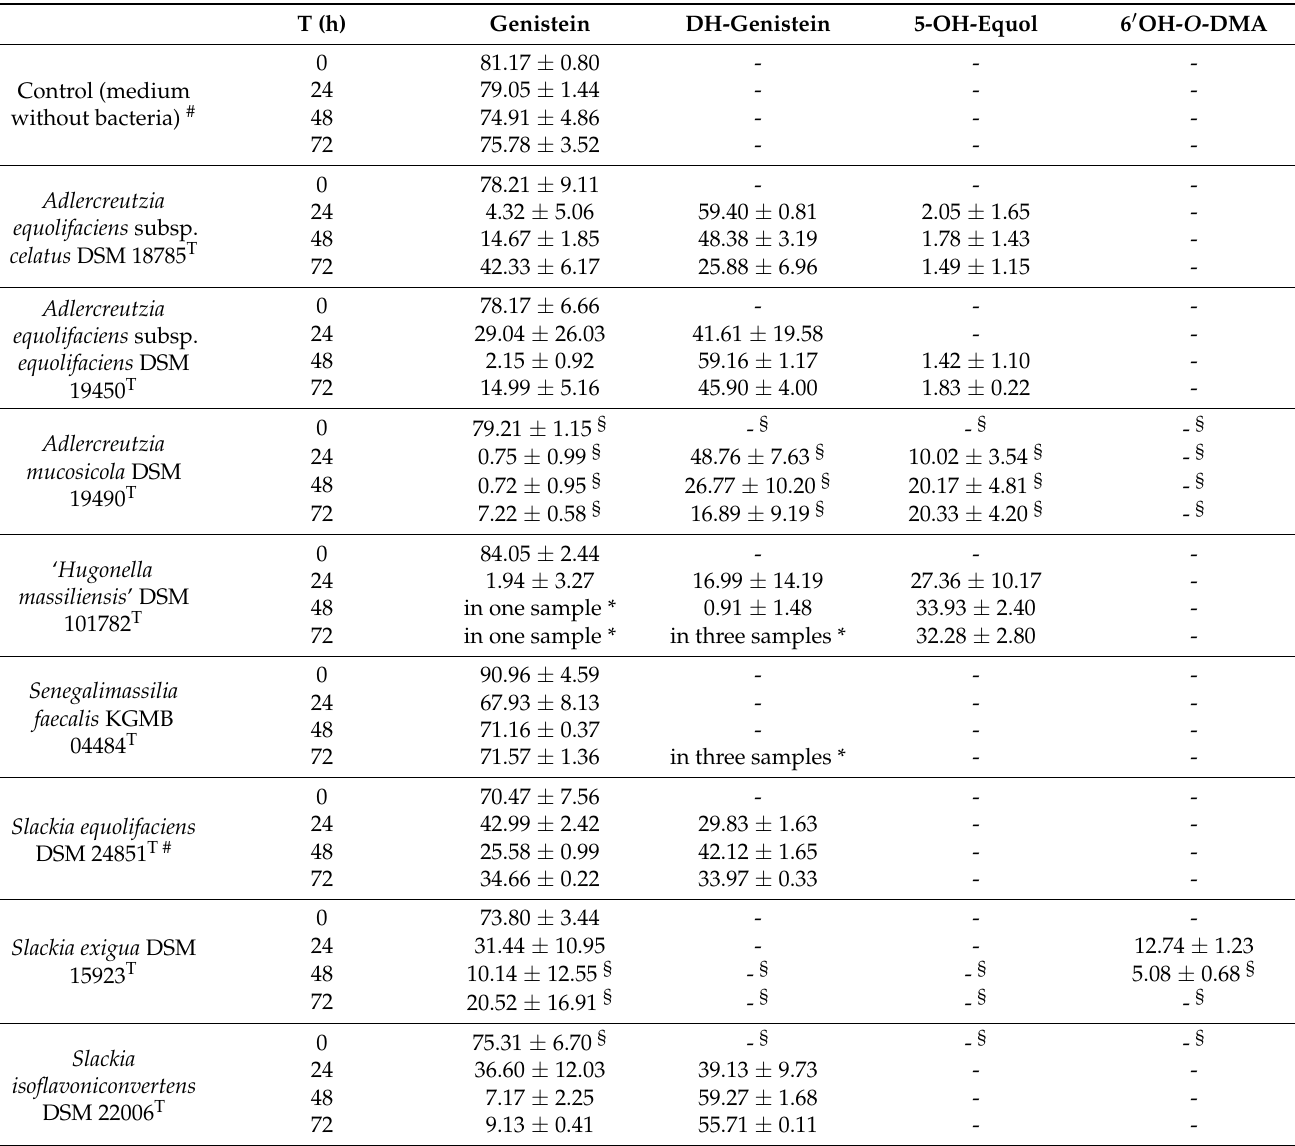
* Detected values ≥ LOD, but below LOQ. # Reported values are from one representative experiment ( n =